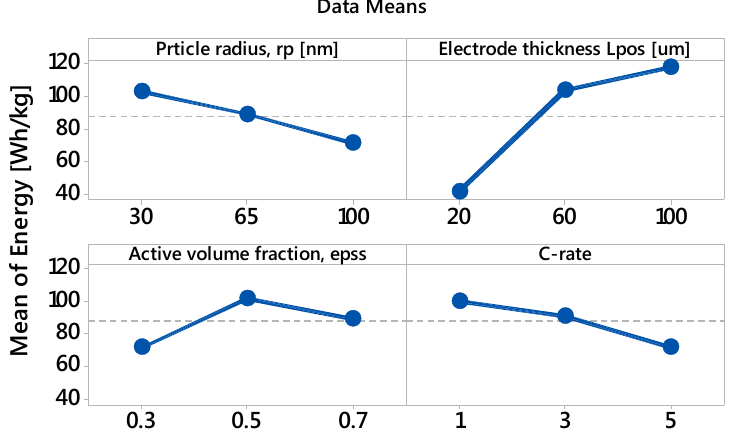
Figure 4. Main effect plot for the specific energy as a function of particle size ( r p ), electrode thickness ( L pos ), volume fraction of the active material ( ε s , pos ), C-rate, at different